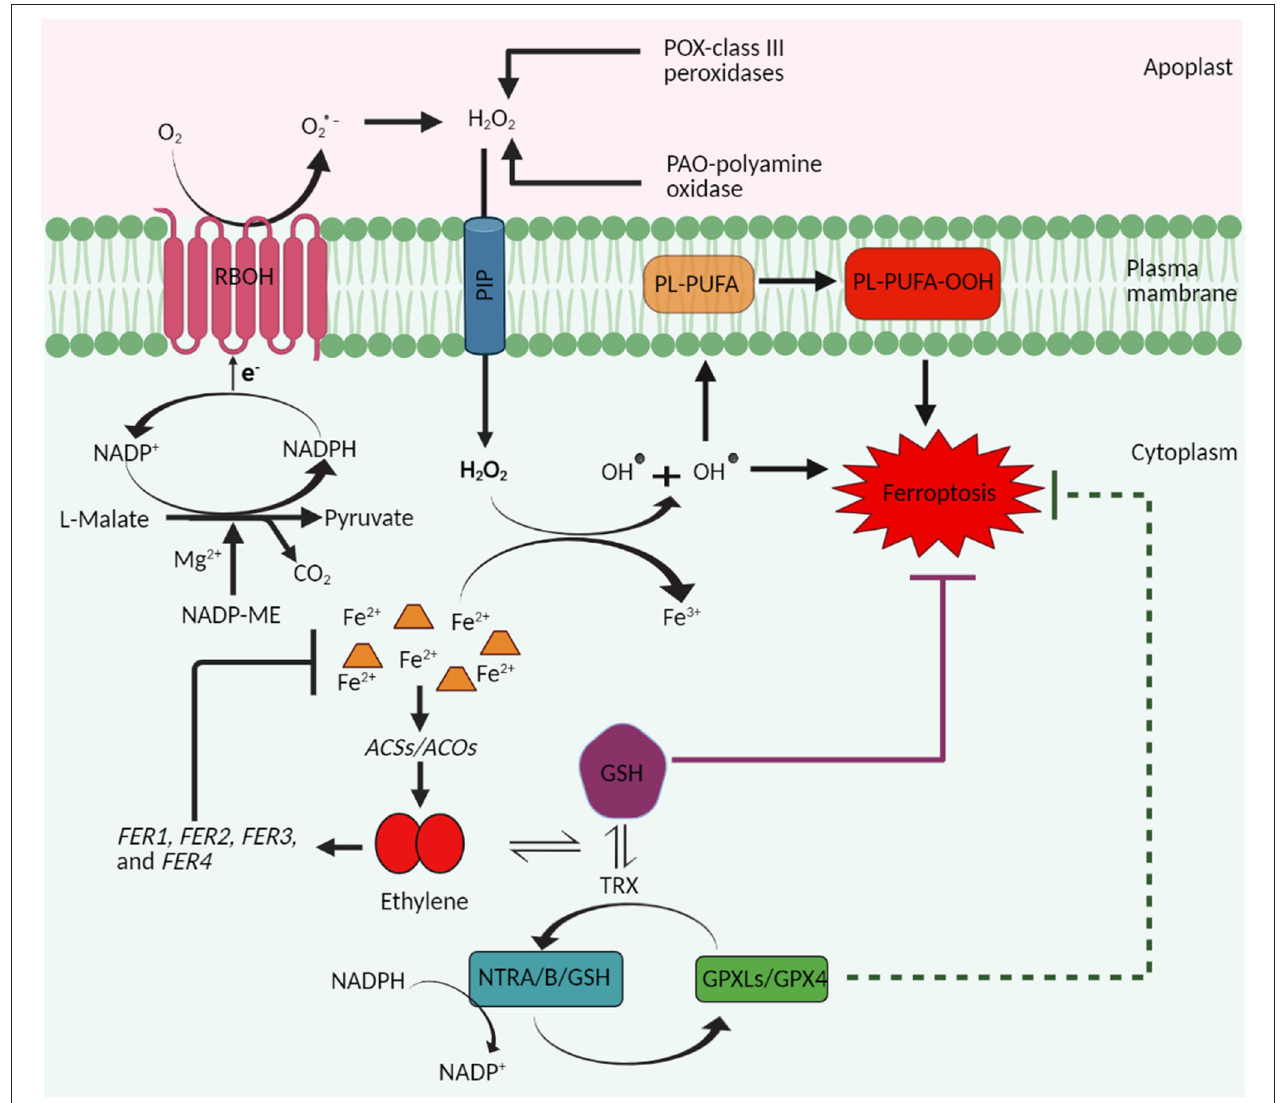
FIGURE 1 | A schematic representation highlighting the proposed role of ethylene in ferroptosis cell death in plants. Plant ferroptosis is characterized by the increase in ROS and subsequent peroxidation of membrane lipids, accumulation of iron, and depletion of reduced glutathione (GSH). Stress-induced accumulation of ROS is mainly dependent on the activity of plasma membrane-localized NADPH-oxidase (respiratory burst oxidase homolog, RBOH) proteins. NADP-malic enzyme supplies electrons to the RBOH proteins and thus contributes indirectly to ROS production and thus to plant ferroptosis. H 2 O 2 produced in the apoplast, because of the conversion of superoxide radicals (O •− 2 ) and/or the activities of the class III peroxidases (POX) and polyamine oxidases (PAO), enters the cytosol through plasma membrane intrinsic proteins (PIP; aquaporins) and mediates the conversion of Fe 2 + to Fe 3 + through the Fenton reaction. Fe 2 + are otherwise involved in the biosynthesis of ethylene by functioning as a cofactor of enzyme ACC oxidase (ACO). Ethylene so produced triggers the synthesis of ferritin proteins that participate in the sequestration of ions of iron and thus prevent their accumulation, which is a prerequisite for ferroptosis cell death. In addition, ethylene also induces the synthesis of GSH and thus helps to maintain the GSH levels to prevent ferroptosis cell